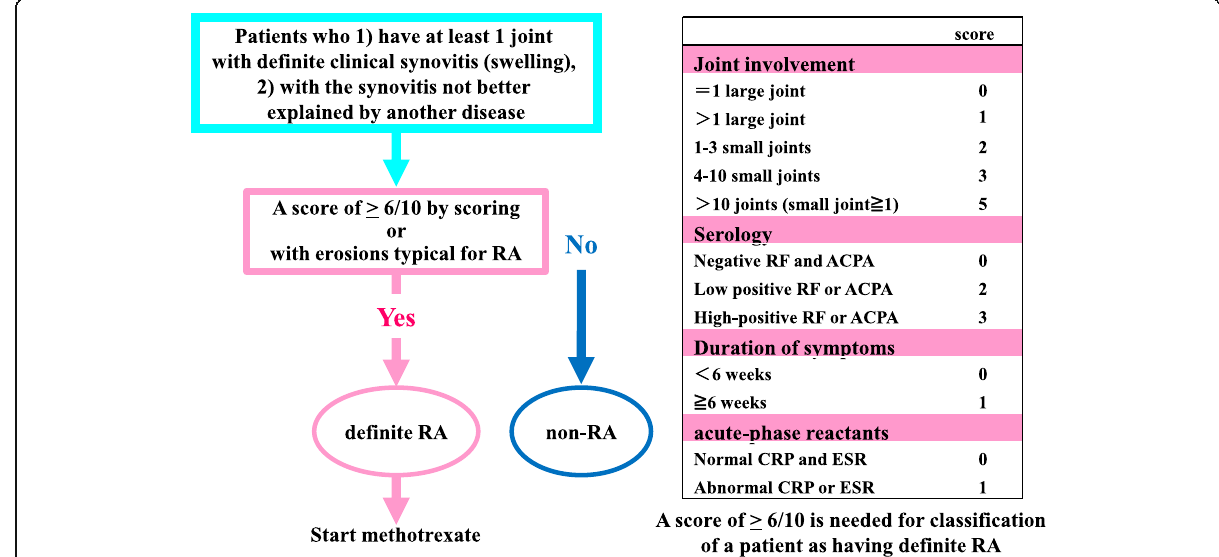
Fig. 1 The rheumatoid arthritis classification criteria published by the ACR/EULAR in 2010. Modified from reference